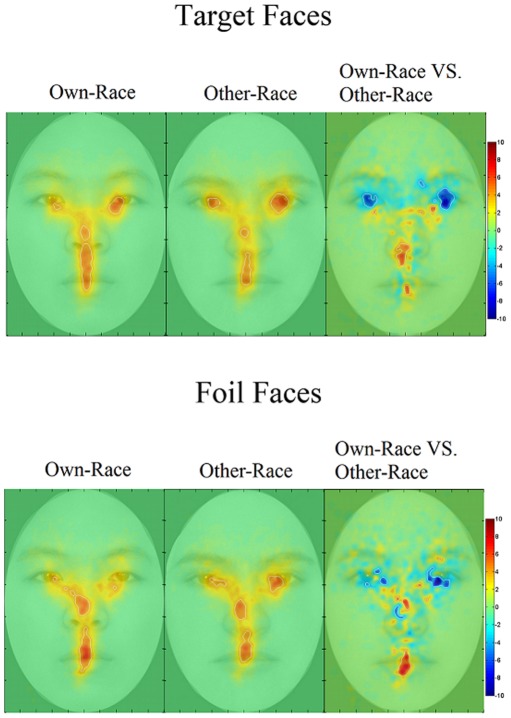
Participants' Raw fixation maps in Z values for viewing own-race Chinese target faces (first column), other-race Caucasian target faces (second column), and the difference between viewing own-race and other-race faces (third column).Areas showing significant fixations are delimited by white borders. (p<0.05, corrected).